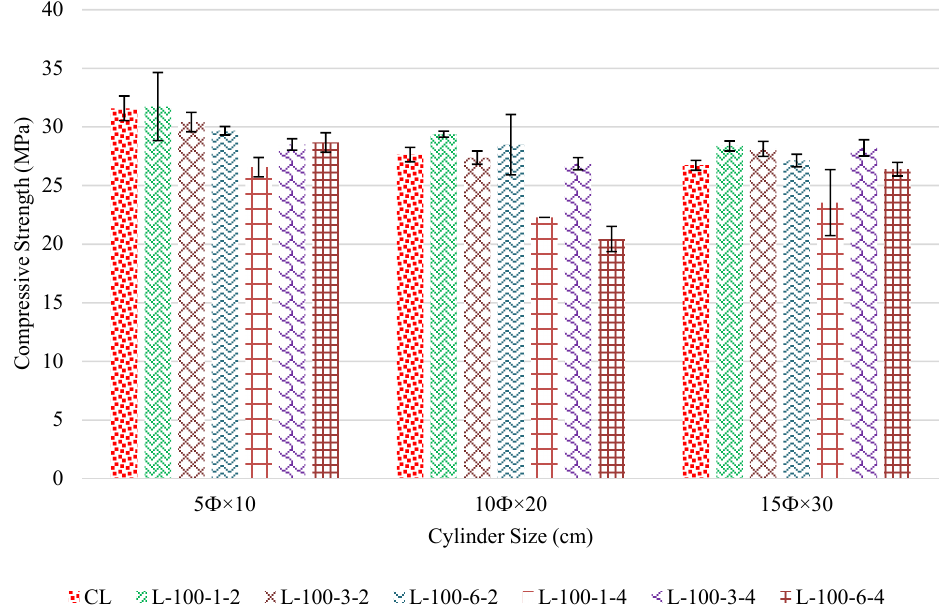
Figure 3. Result of 28-day compressive strength of normal concrete of different size cylinders.